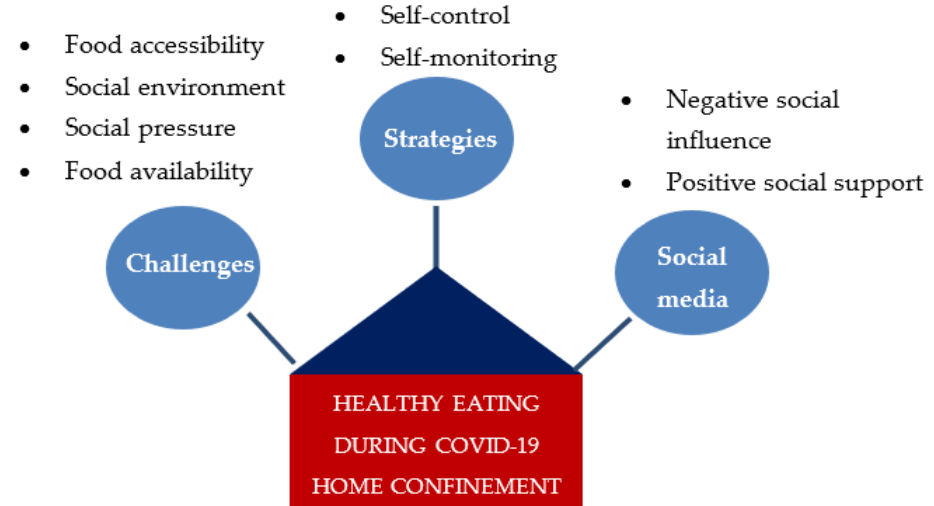
Figure 1. The challenges and strategies to healthy eating, and the roles of social media.